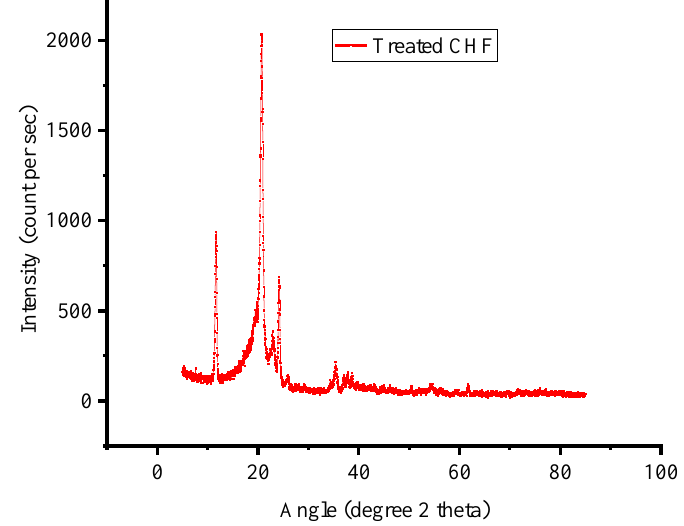
Figure 8. Diffraction of X-rays of NaOH-treated composites.